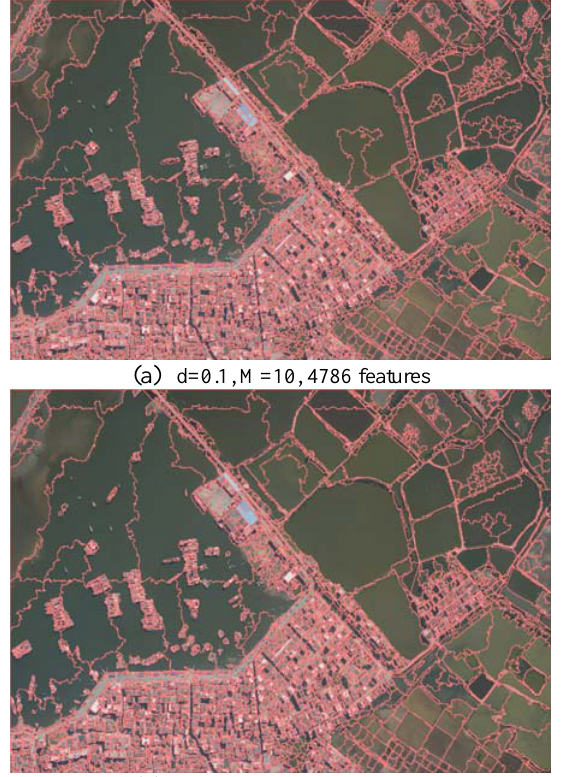
Fig. 5 Segmentation result comparison between the proposed Rule II and the criterion proposed by